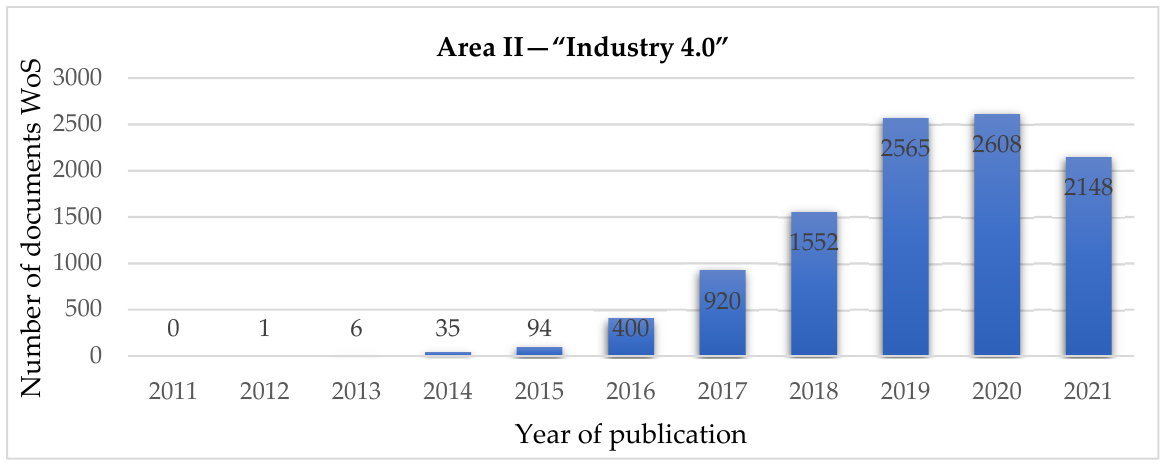
Figure 4. Growth dynamics of published articles in the WoS database from 1 January 2011 to 31 October 2021 in the field of Industry 4.0. Source: own elaboration.